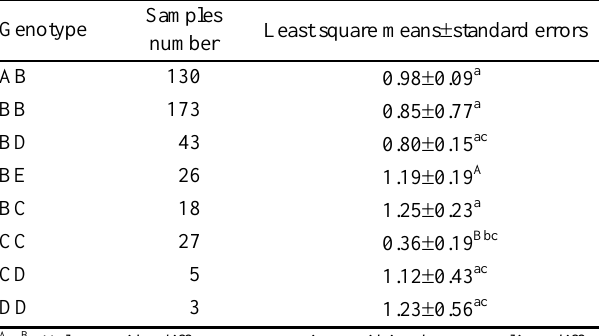
A, B Values with different superscripts within the same line differ significantly at p<0.01. a, b, c Values with different superscripts within the same line differ significantly at